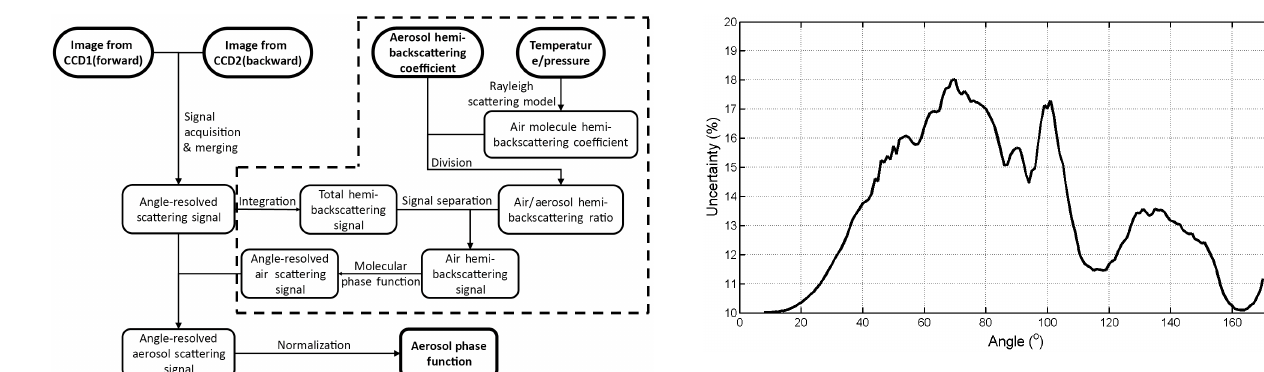
Figure 5. Uncertainties of the merged angle-resolved signal from CCD-LADS